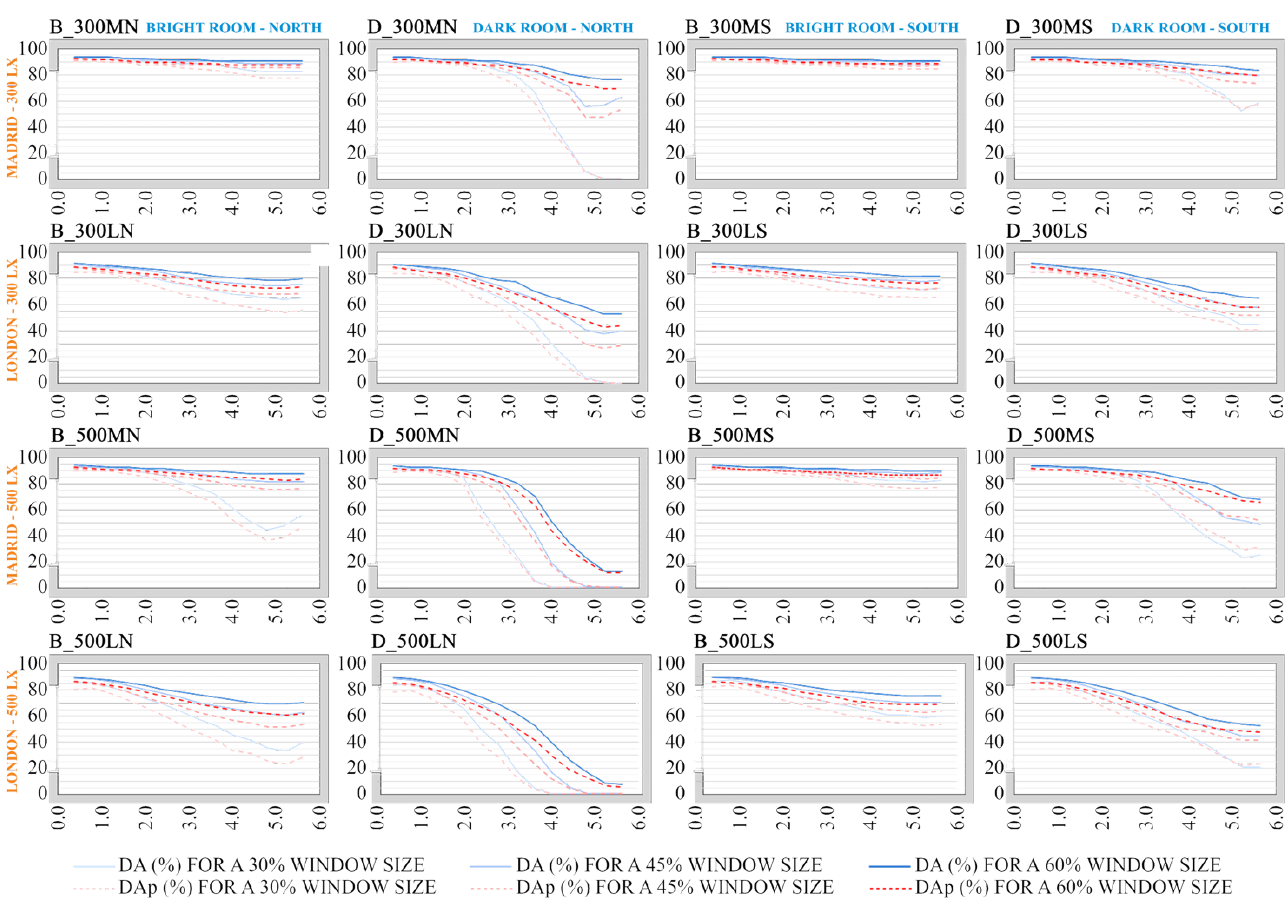
Figure 4. Quantification of DA and DAp in the calculation models according to Window-to-Wall Ratio (WWR).